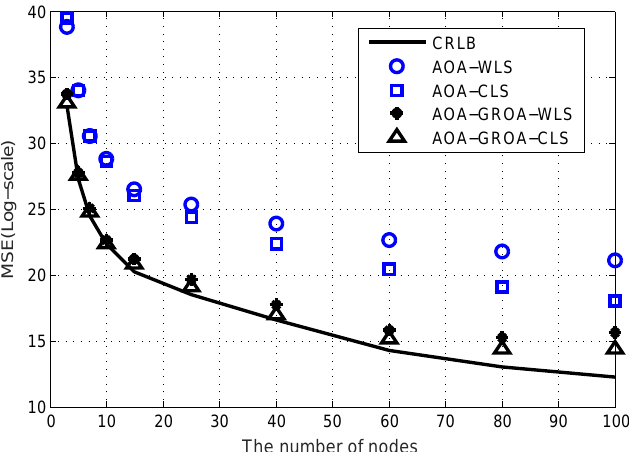
Figure 6. Average MSE results of AOA-only WLS, AOA-only CLS, AOA-GROA WLS and AOA-GROA CLS methods with respect to various number of nodes, σ AOA = 0.01 radian, σ GROA = 3 × 10 − 3 and σ s = 10 − 2